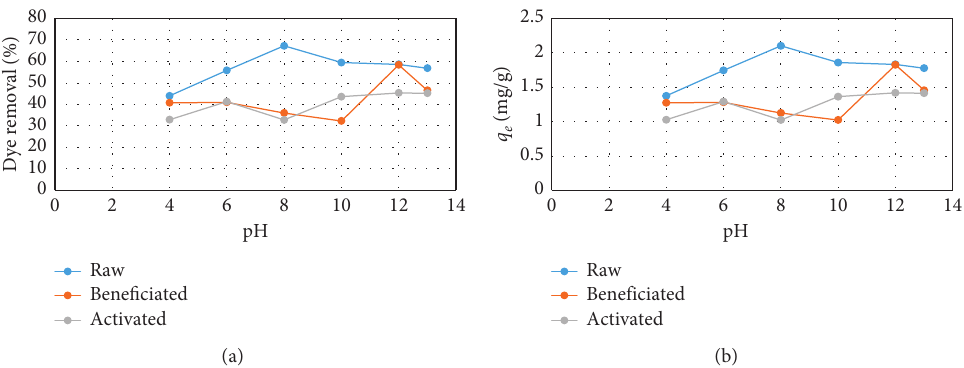
Figure 5: (a) Effect of pH on the removal (%) of MB by raw, beneficiated, and activated waste ashes. (b) Effect of pH on the adsorption capacity (mg/g) of MB by raw, beneficiated, and activated waste ashes.